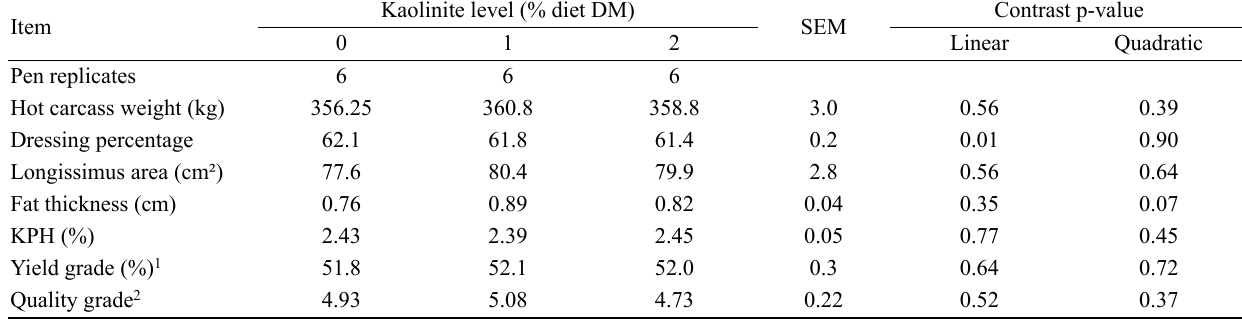
Table 5. Influence of supplementation level of kaolinite clay on carcass characteristics of Holstein steers